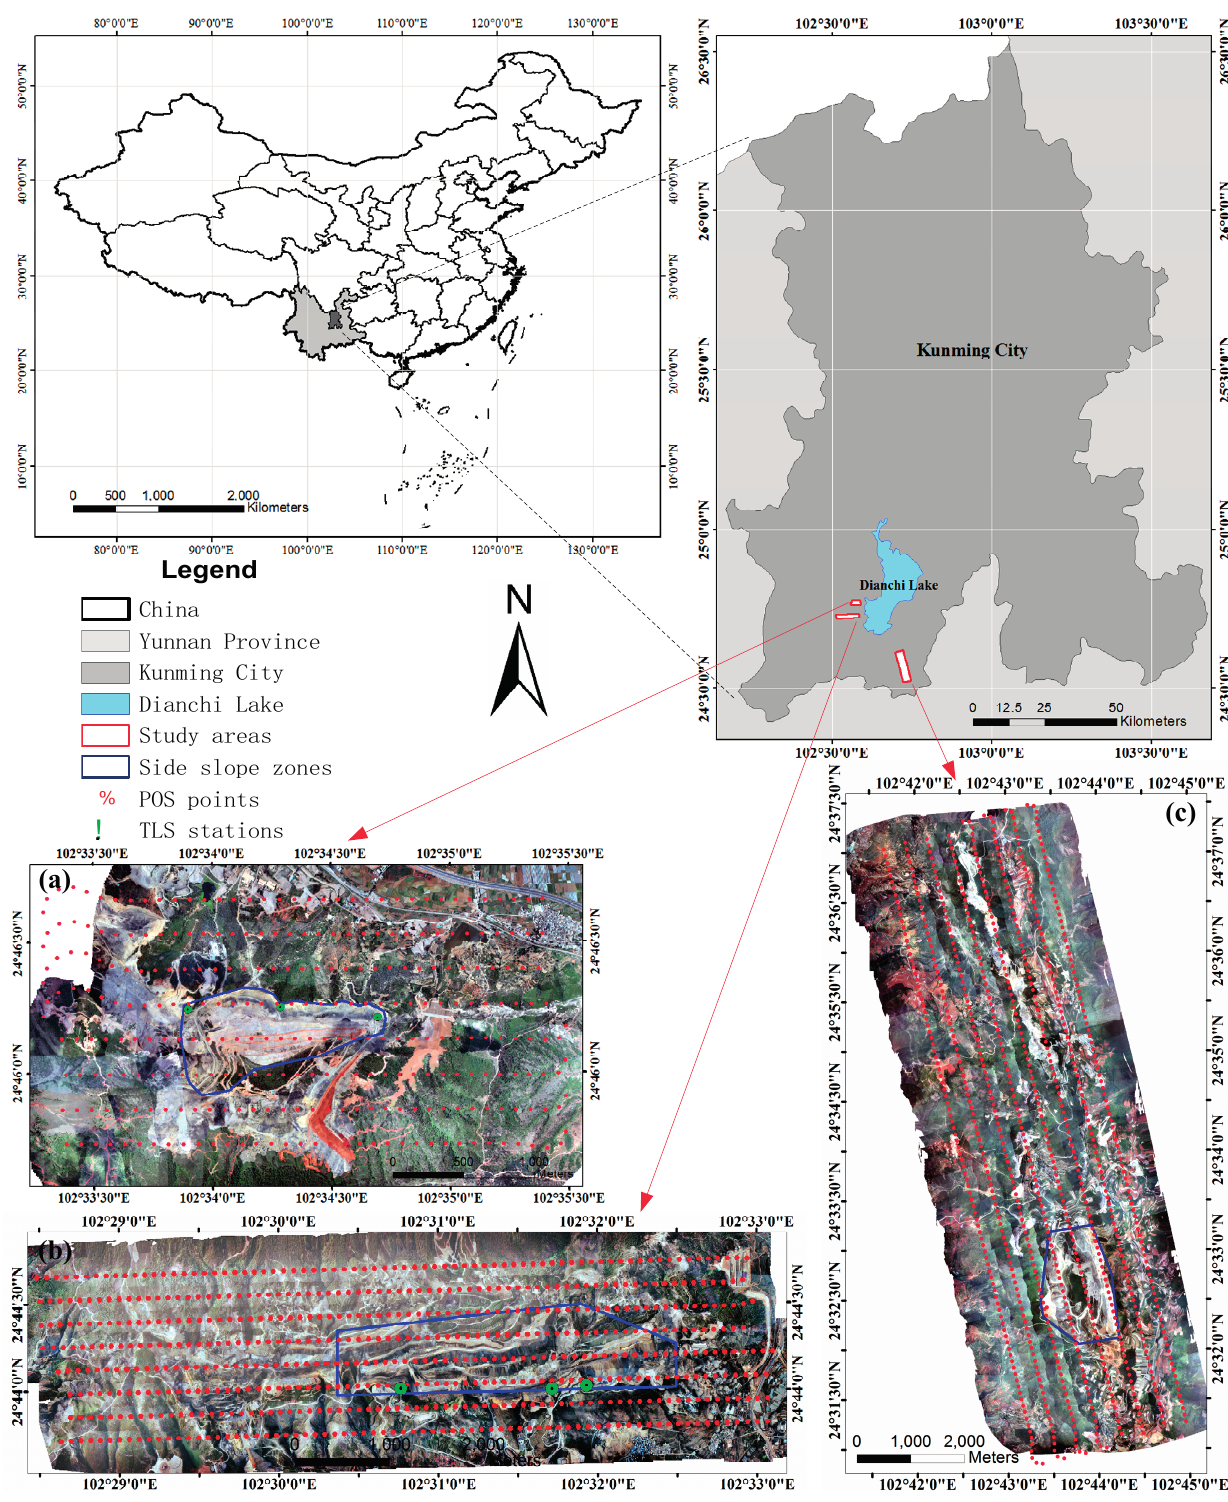
Figure 3. The study area in southwestern China. The UAV flight areas are delineated as red polygons, the side slope zones are delineated as blue polygons, the planimetric positions of the photo centres are delineated as red points, and the TLS positions are delineated as green points. ( a ) Jianshan open-pit mine area; ( b ) Kunyang open-pit mine area; and ( c ) Jinning open-pit mine